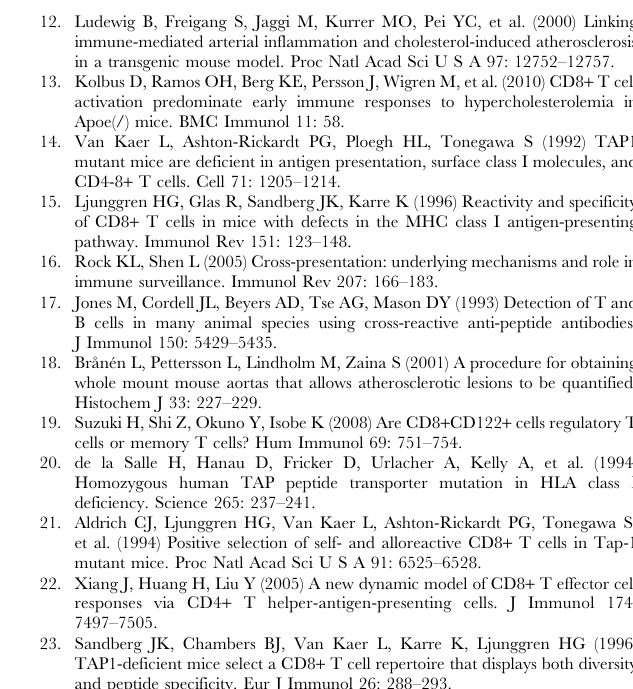
Figure S1 Effector memory CD4 + T cells and CD8 + T cells in spleen and MeLN. The fraction of (A)